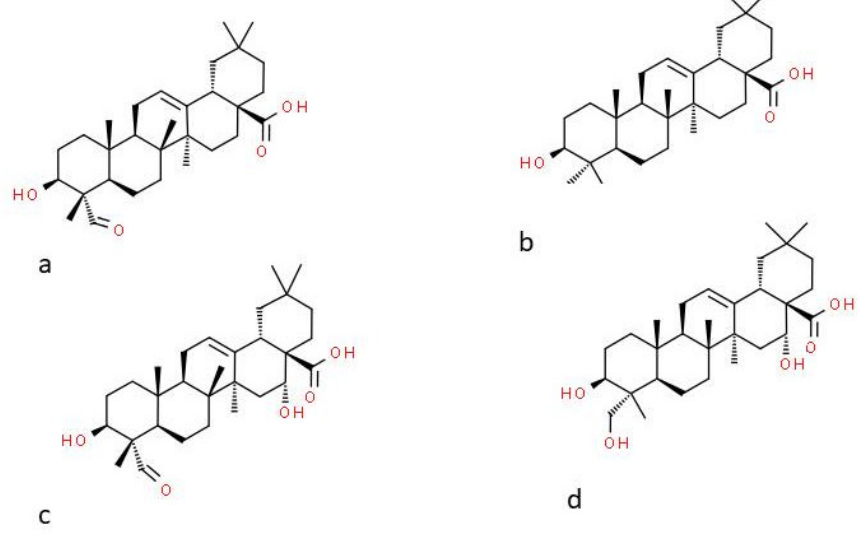
Figure 3. Aglycones structure (a: gypsogenin, b: hederagenin, c: quillaic acid, d: hydroxyhederagenin) (Source: